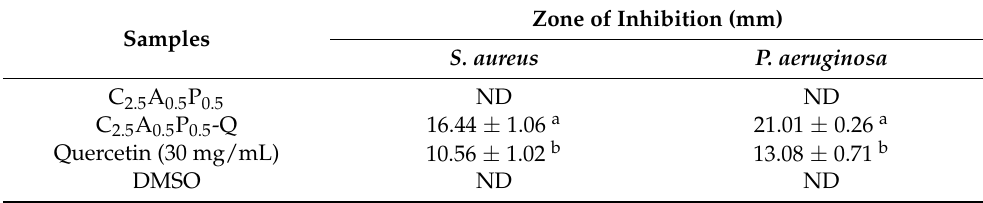
Table 3. Anti-bacterial activity of the WHC-composited hydrogel against S. aureus and P. aeruginosa .